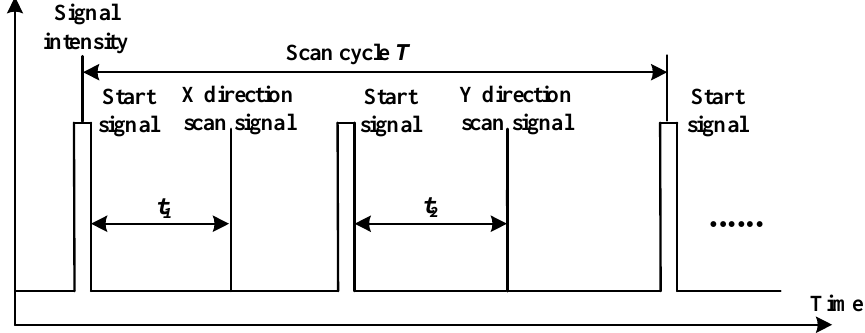
Figure 2. Sample pulse train received by a photodiode on a tracked object. Distance between pulses are not to scale.